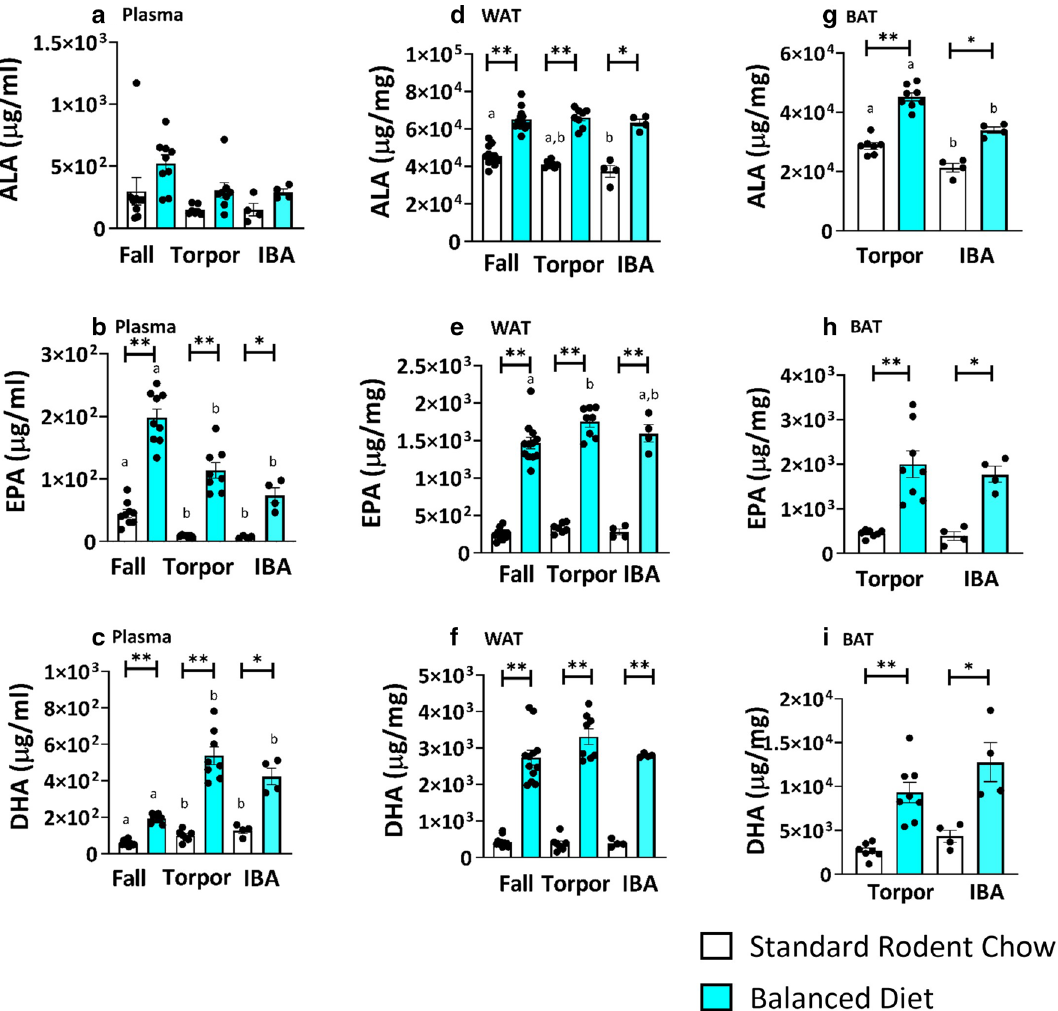
Figure 3. Feeding Balanced Diet leads to high omega 3 PUFAs in plasma and adipose tissue. ( a ) Plasma DHA and EPA are increased in Balanced Diet (BD) at all time points compared to Standard Rodent Chow (SRC) (*p < 0.05, **p < 0.001, t-test, FDR corrected, fall n = 9, torpor n = 7–8, IBA n = 4). Seasonal comparisons within the same diet found DHA was highest in torpor and IBA (post hoc Tukey, letters (a or b) within a given diet signify differences between phenotypic states within that diet). ( b ) WAT ALA, EPA and DHA are significantly increased in BD AGS compared to SRC AGS in all time points (*p < 0.05, **p < 0.001, t-test, FDR corrected, fall n = 11–12, torpor = 7–8, IBA = 4). ( c ) BAT ALA, EPA and DHA are significantly higher in BD AGS compared to SRC AGS in torpor and IBA (*p < 0.05, **p < 0.001, t-test, FDR corrected, torpor = 7–8, IBA = 4). Comparisons between torpor and IBA within the same diet found ALA decreased in IBA compared to torpor (t-test, FDR corrected, letters (a or b) within a given diet signify differences between phenotypic states within that diet). Fall BAT was not sampled. Data shown are mean ± SEM. Black dots are individual data